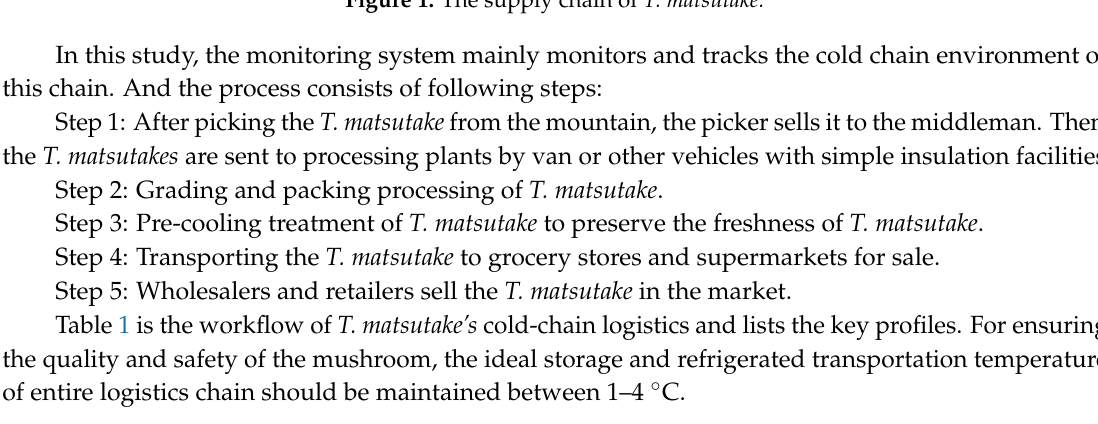
Table 1. Workflow of T. matsutake’s cold-chain logistics.